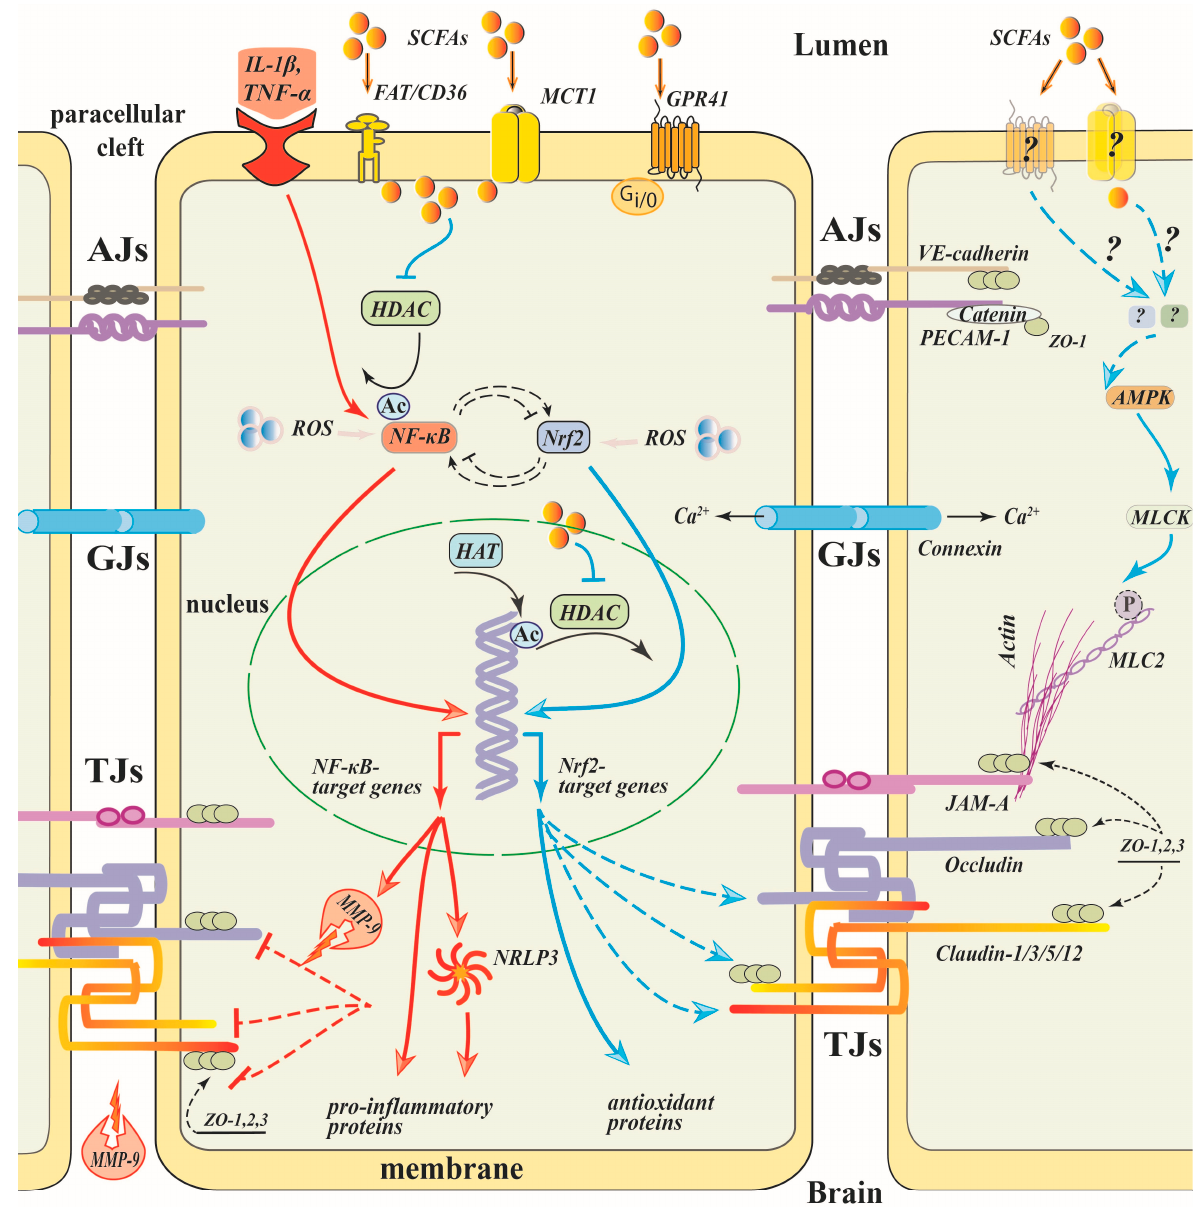
Figure 2. Mechanisms of SCFA effects on a brain endothelial cell (Part 1). Pathological stimuli activate NF- κ B-mediated expression of multiple genes, including MMP-9 and NLRP3, and cause the degradation of TJ proteins. Activation of Nrf2 counteracts the NF- κ B-driven inflammatory response. SCFAs suppress NF- κ B and promote Nrf2 activation, leading to the recovery of TJPs. SCFAs can act after entry via transporters (MTC1, FAT/CD36) or via binding to receptors (e.g., GPR41). SCFAs inhibit HDAC, which results in an increase in histone acetylation, facilitating expression of genes, including Nrf2, that contribute to BBB integrity, and increase NF- κ B acetylation, inhibiting its transcriptional activity. Under pathological stimuli, MLCK phosphorylates MLC2 to form actin stress fibers resulting in the endocytosis of transmembrane TJPs and loss of BBB integrity. SCFAs may promote the reassembly of TJs via suppression of the MLCK/MLC2 pathway. Dotted lines—putative signaling pathways. Blue lines—positive effects; red lines—negative effects. Symbols on the scheme—see in the list of